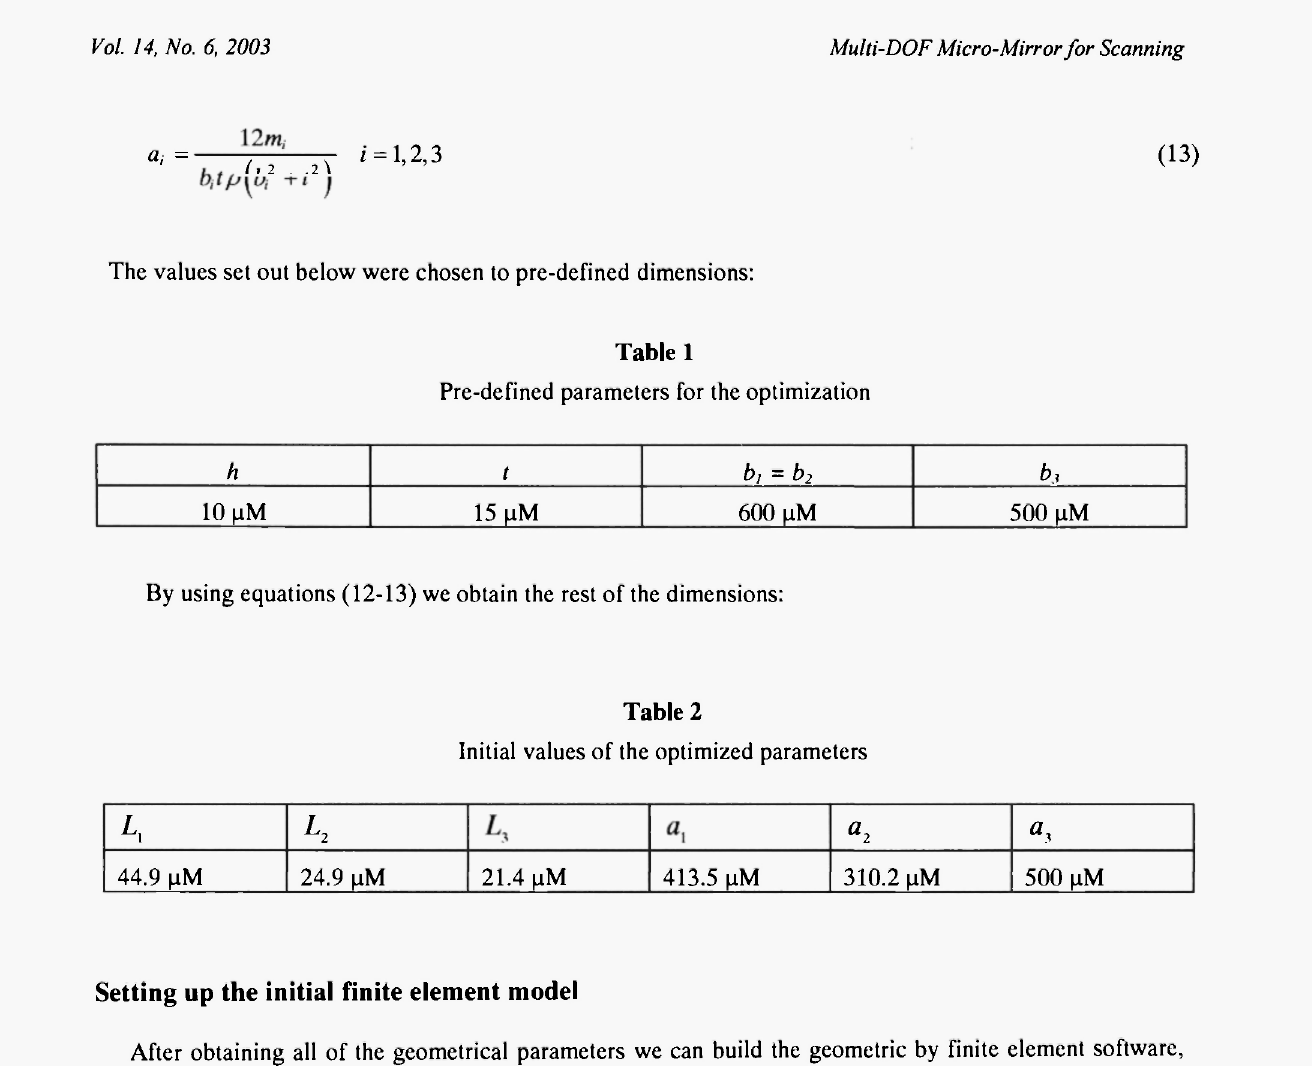
Pre-defined parameters for the optimization